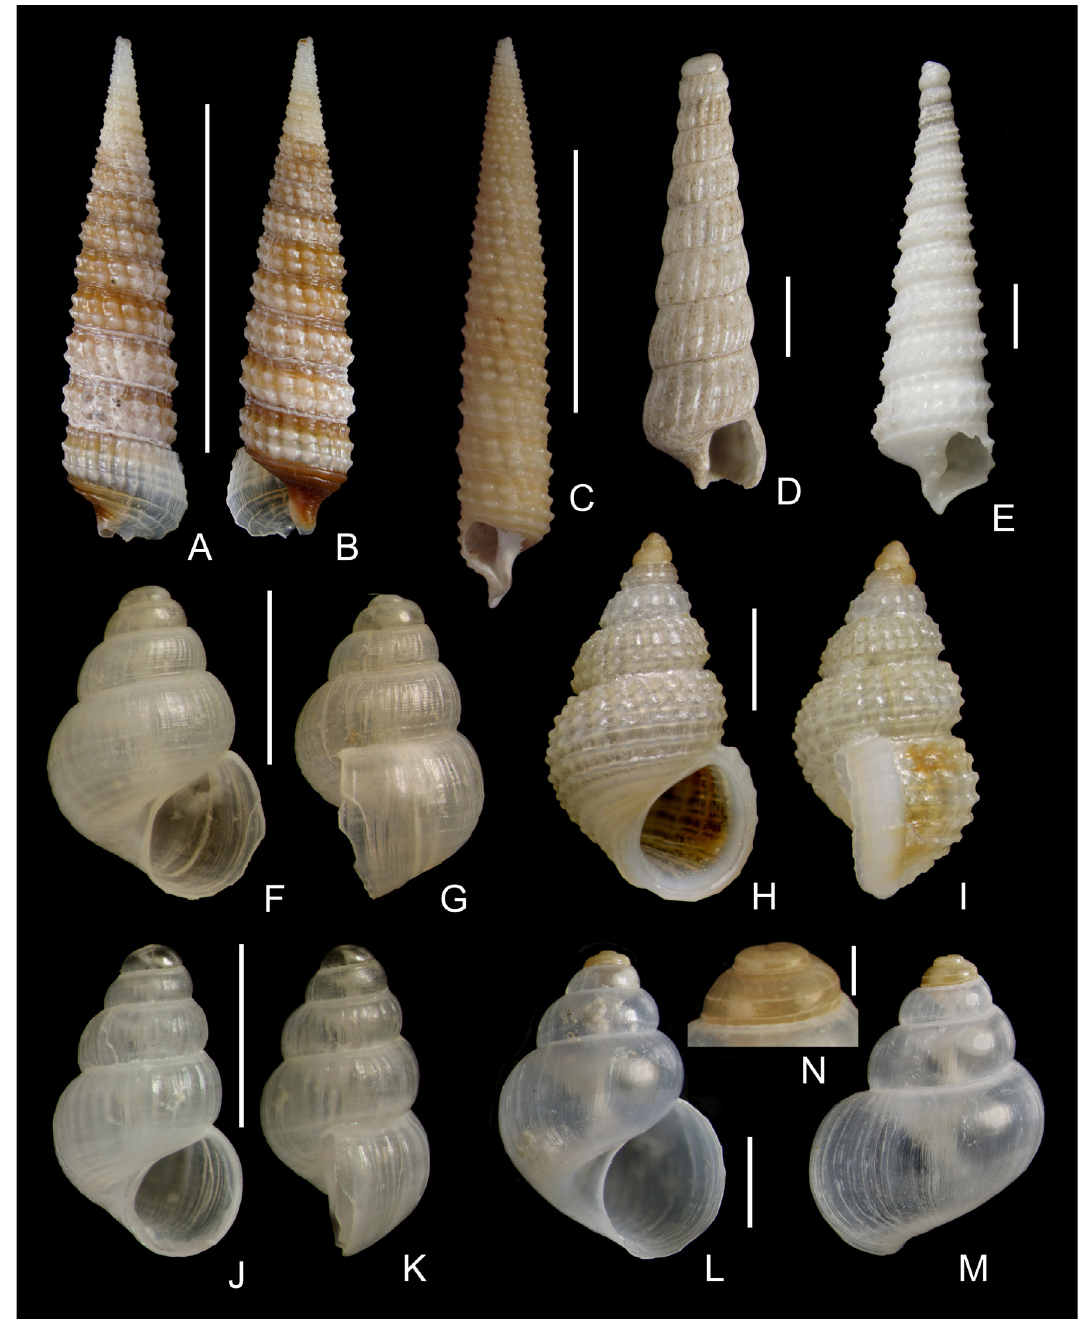
Fig. 21. Triphoridae, Newtoniellidae, Rissoidae. A–B . Strobiligera lubrica (Bouchet & Warén, 1993), BANGAL 0711, V8, 1565 m, 14.6 mm. C . Strobiligera brychia (Bouchet & Guillemot, 1978), SEAMOUNT 1, DW116, 985–1000 m, 21.5 mm. D . Eumetula bouvieri (Dautzenberg & H. Fischer, 1896), BANGAL 0711, DR15, 1410 m, 5.5 mm. E . Cerithiella metula (Lovén, 1846), BANGAL 0711, V10, 1720 m, 7.0 mm. F–G . Alvania porcupinae Gofas & Warén, 1982, BANGAL 0711, DR15, 1.8 mm. H–I . Alvania cimicoides (Forbes, 1844), SEAMOUNT 1, DW108, 1110–1125 m, 3.6 mm. J–K . Gofasia galiciae Bouchet & Warén, 1993, BANGAL 0711, DR15, 1.7 mm. L–N . Benthonella tenella (Jeffreys, 1869), BANGAL 0711, V5, 1631 m, 3.4 mm, and detail of the protoconch. Scale bars: A–C = 10 mm; D–M = 1 mm; N = 200